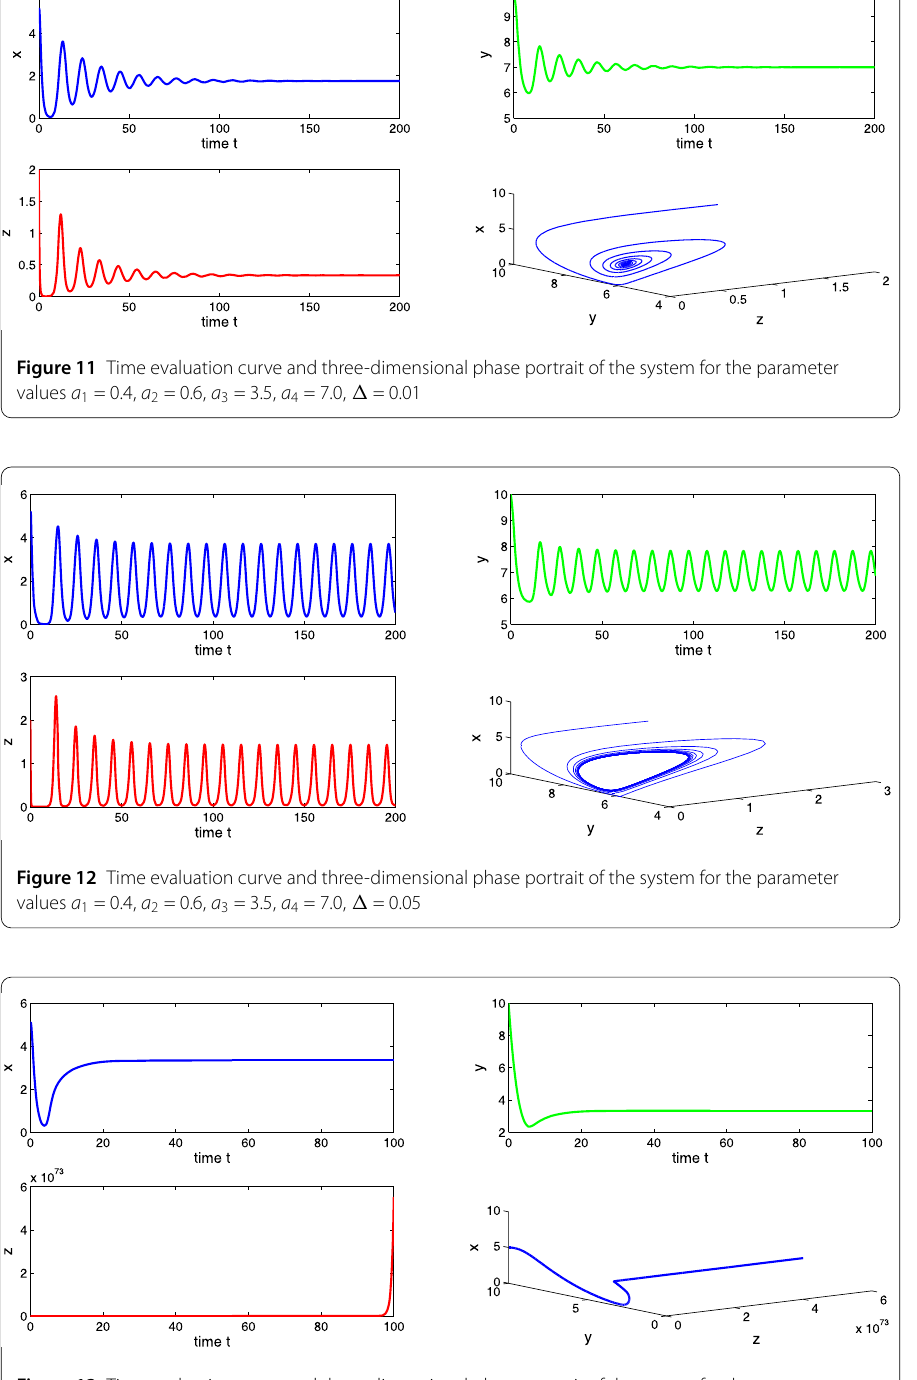
we get tumor-free equilibrium E 1 as unstable and co-axial equilibrium E 2 as stable in na- ture. From Figs. 11 and 12, we observe a stability switch in the system (2.2) as the delay factor (cid:5) crosses a